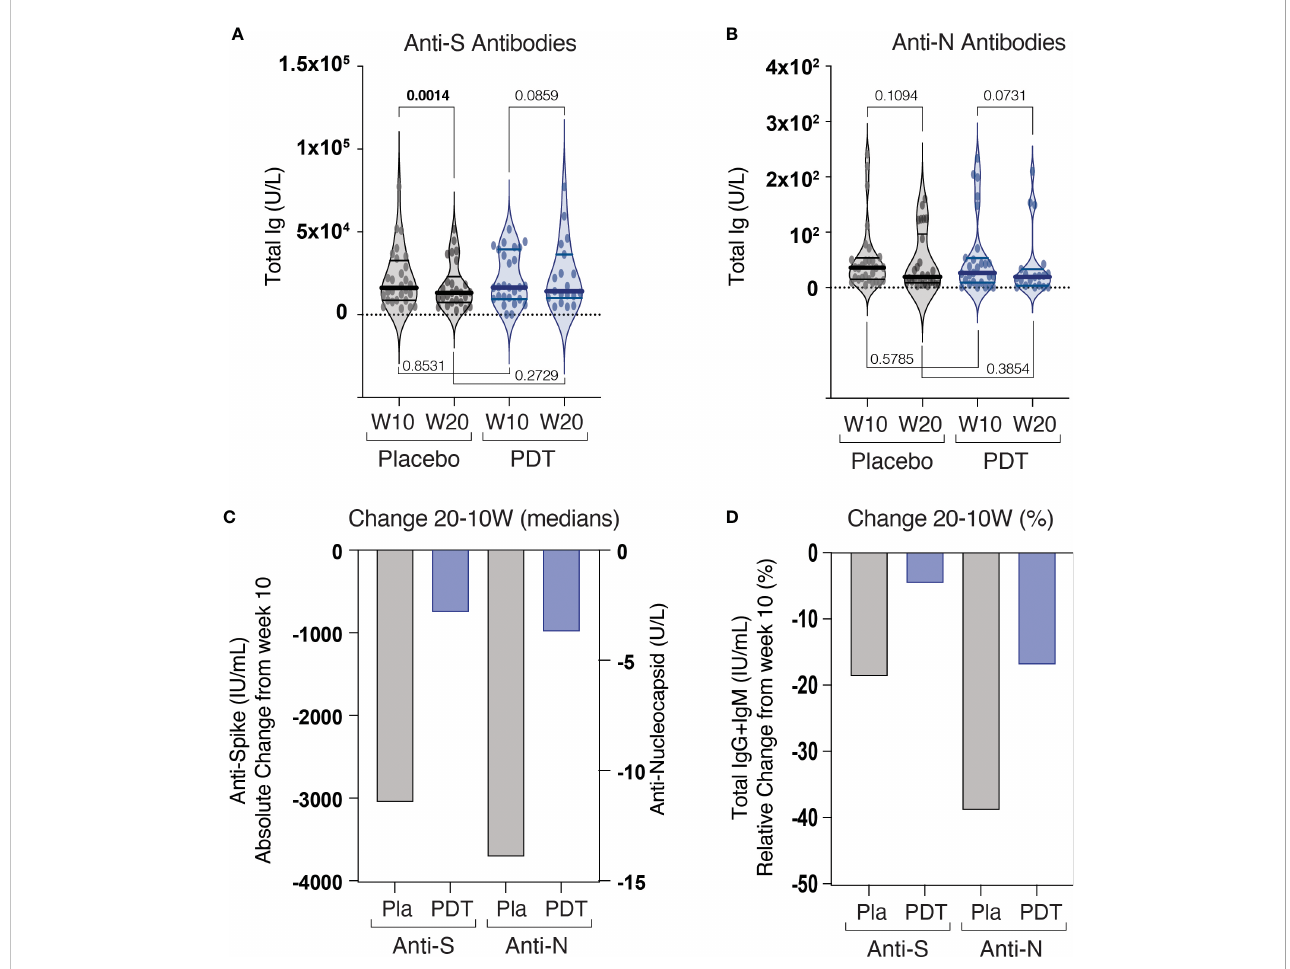
FIGURE 3 Results of humoral immunity assays. Patients were followed up after intranasal PDT treatment for 20 weeks. On week 10 and week 20, a sample of plasma and peripheral CD4 and CD8 T lymphocyte was collected (A) Detection of plasma total anti-Spike antibodies. (B) Detection of plasma total anti- Nucleocapsid antibodies. (C) Change of median levels at 20 weeks when compared to 10 weeks. (D) Percentage of change of median antibody levels at 20 weeks with respect to 10 weeks. Anti-S, Anti-Spike, Anti N, Anti Nucleocapsid, W10, 10 th week after End of treatment, W20, 20 th week after End of treatment, PDT, Pthotodynamic